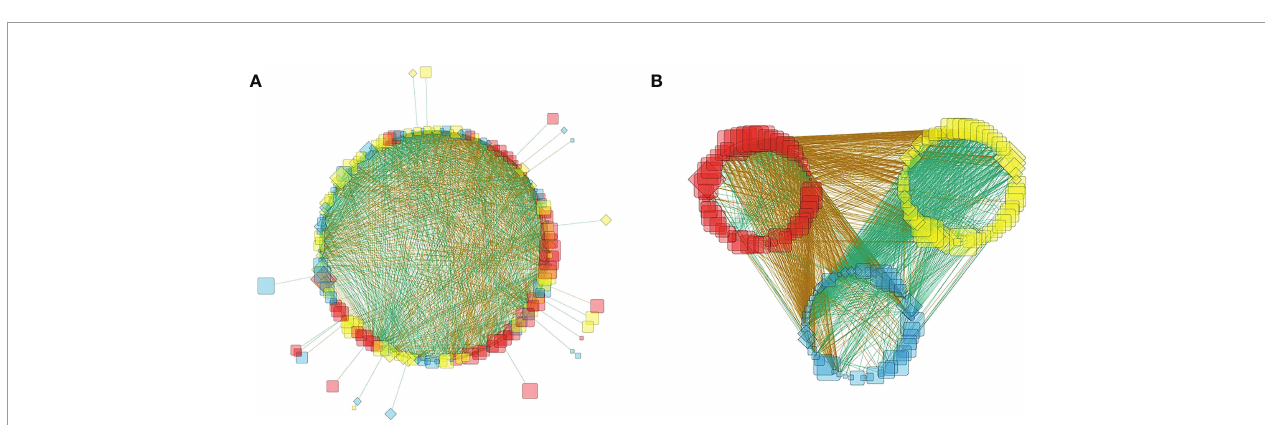
FIGURE 5 | Percentage of family and corresponding OTUs of (A) bacteria and (B) archaea viewed with relation with DI. Color indicates the relation between OTUs and DI: Red-negative, yellow-positive, blue-no relation. Note that OTU<100 is not considered here to avoid fake relations due to too less data. Photo by